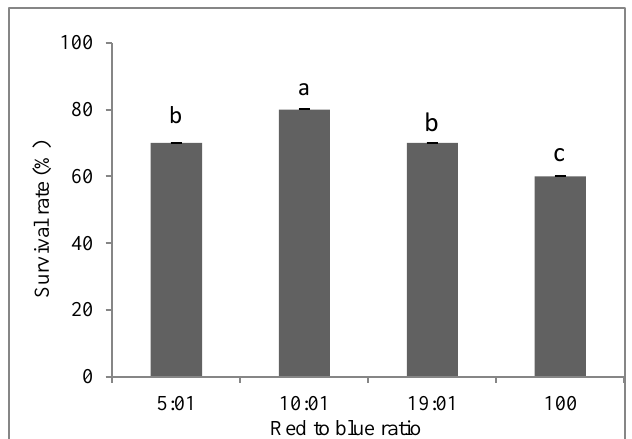
Figure 2. Surviving rate of tomato plantlets under different ratios of R to B LED light. Mean separation within columns by Tukey’s HSD tests ( n = 5). Values labeled with different letters in a column are significantly different ( p < 0.05).